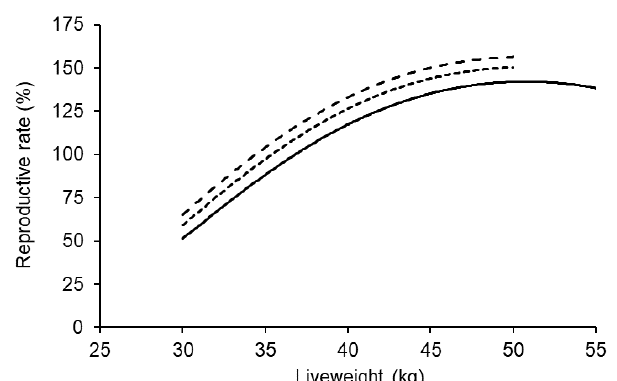
Figure 4. The effect of liveweight at the start of breeding on reproductive rate for ewe lambs that were born a single (bottom), twin or triple (top). The data represent over 11,500 maternal composite ewe lambs and reproductive rates are predicted at 7.5 months of age. The average 95% confidence interval across all scenarios was ±10.0%.